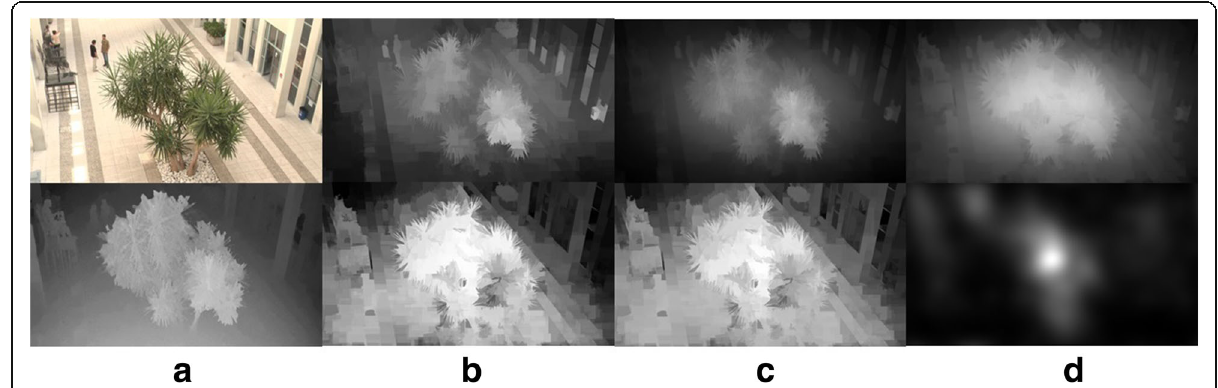
Fig. 7 An example of the proposed visual saliency prediction. a The original left image and depth map. b The maps computed by the stereo contrast and stereo focus models. c The maps after clustering. d Final saliency map and ground